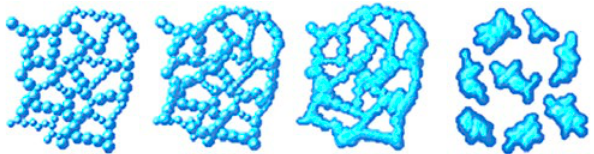
Figure 55. Stages in the aging of a gel are illustrated from the chaining of spheres and their greater coalescence, to the coarsened structure which results from drying or heating where the structure disintegrates to irregular rounded particles. [Adapted from Iler 2 , 1979, p. 530]